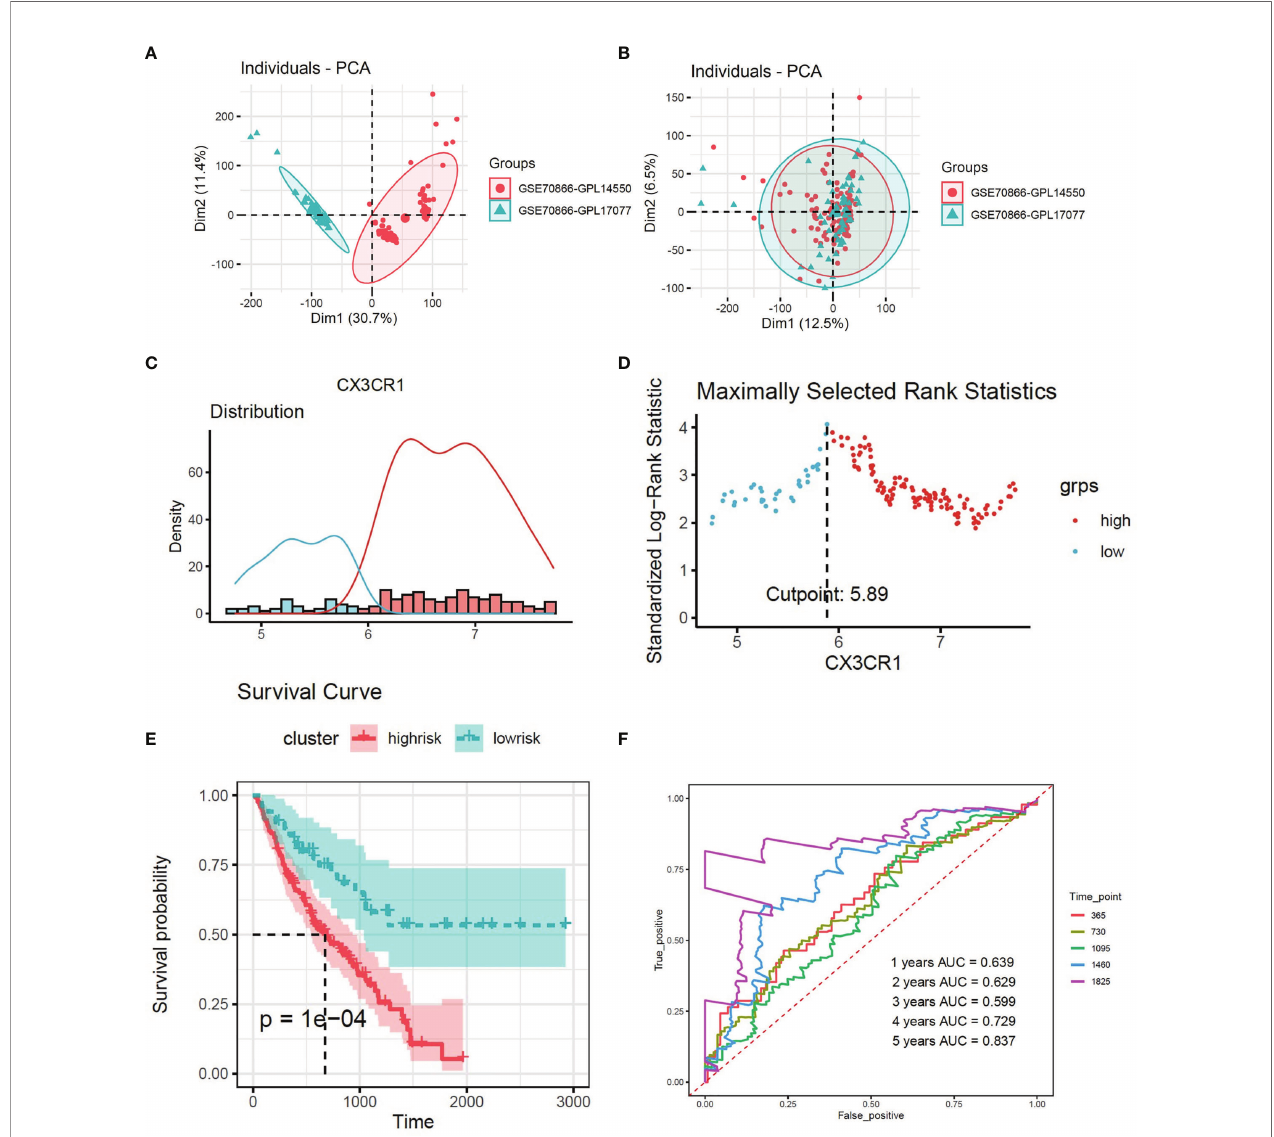
FIGURE 2 | (A, B) Removing the batch effect between different sequencing platforms. (C) Histogram based on maximally selected rank grouping. (D) The cut-off point with the maximum standard log-rank statistic was marked with a vertical dashed line. (E) Kaplan – Meier plot of overall survival in two clusters based on the risk models of CX3CR1(Risk score1). (F) The ROC curve in the risk models of CX3CR1(Risk